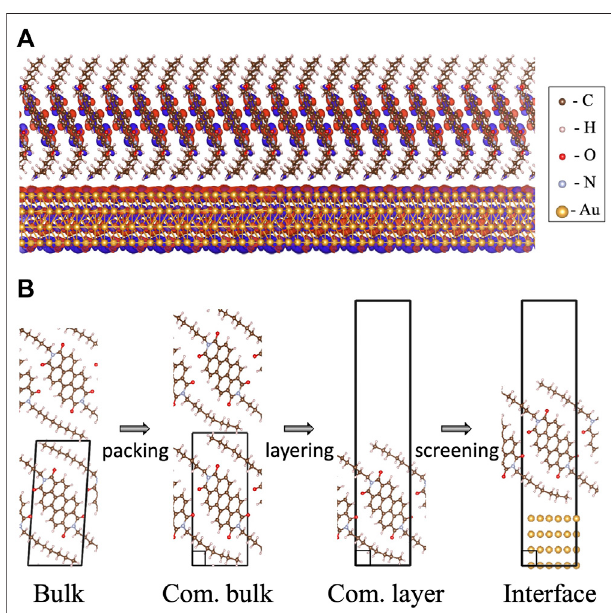
FIGURE 1 | (A) The examined C8-PDI@Au metal-organic interface composed ofan organic monolayer, commensurate with a four-layer Au (111) surface. The charge distribution computed for the lowest bound singlet exciton is also shown. (B) The different structural modi fi cations of the interface compositions as examined in this work: C8-PDI intermolecular packing, layering, and adsorption on Au surface. The four main structures discussed in the text are termed as “ bulk ” , for the experimental triclinic crystal structure (Briseno et al., 2007); “ com. bulk ” , for an arti fi cial construction of a commensurate phase; “ com. layer ” , for a monolayer structure of the commensurate phase; and “ interface ” , for an interface formed between the commensurate monolayer and four layers of Au